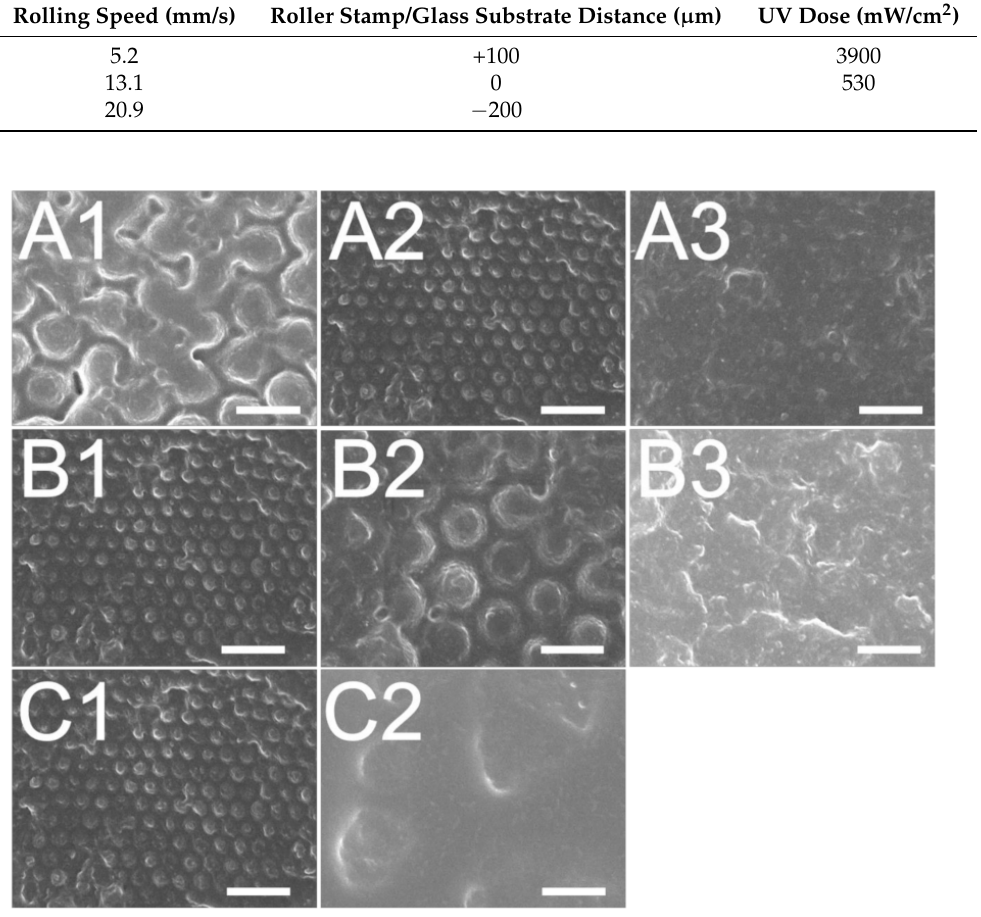
Figure 11. Effect of ( A ) roller stamp/glass substrate distance; ( A1 ): +100 µ m, ( A2 ): 0 µ m, a3: − 200 µ m, ( B ) rolling speed; ( B1 ): 5.23 mm/s, ( B2 ): 13.08 mm/s, ( B3 ): 20.93 mm/s, ( C ) UV dose; ( C1 ): 3900 mW/cm 2 , ( C2 ): 530 mW/cm 2 , on the fabrication of 300 nm nanofeatured